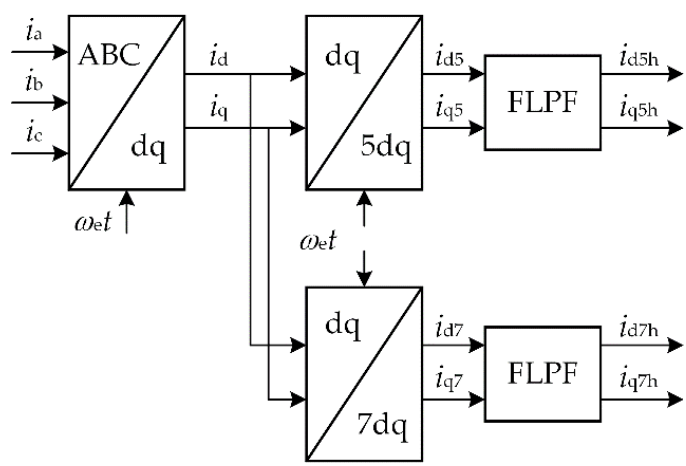
Figure 1. The block diagram of traditional method of current harmonic extraction. In order to improve the extraction accuracy without increasing the complexity of the algorithm, the fundamental component is subtracted before the MSRFT of the dq axis currents in this paper. The fundamental component is considered as the dq axis currents reference value. As a result, the problem of high-amplitude alternating current under the 5th and 7th synchronous rotating frames can be avoided. Then, the extraction accuracy of current harmonics can be improved. The block diagram of the proposed method is shown in Figure 2.